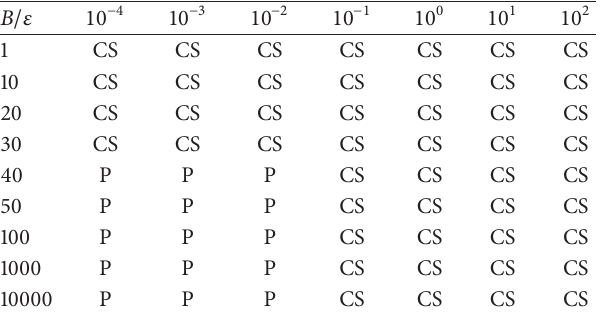
Table 3: Behavior of solutions with diffusion ( ] ̸=0 ) for different values of the viscoelastic characteristic time, 𝜀 (rows), and the temperature gradient, B (columns). We introduce the following notation to account for the obtained numerical results: “C” denotes a fully chaotic behavior, “CS” a transition from chaotic outburst to stable equilibria, and “P” a periodic orbit.